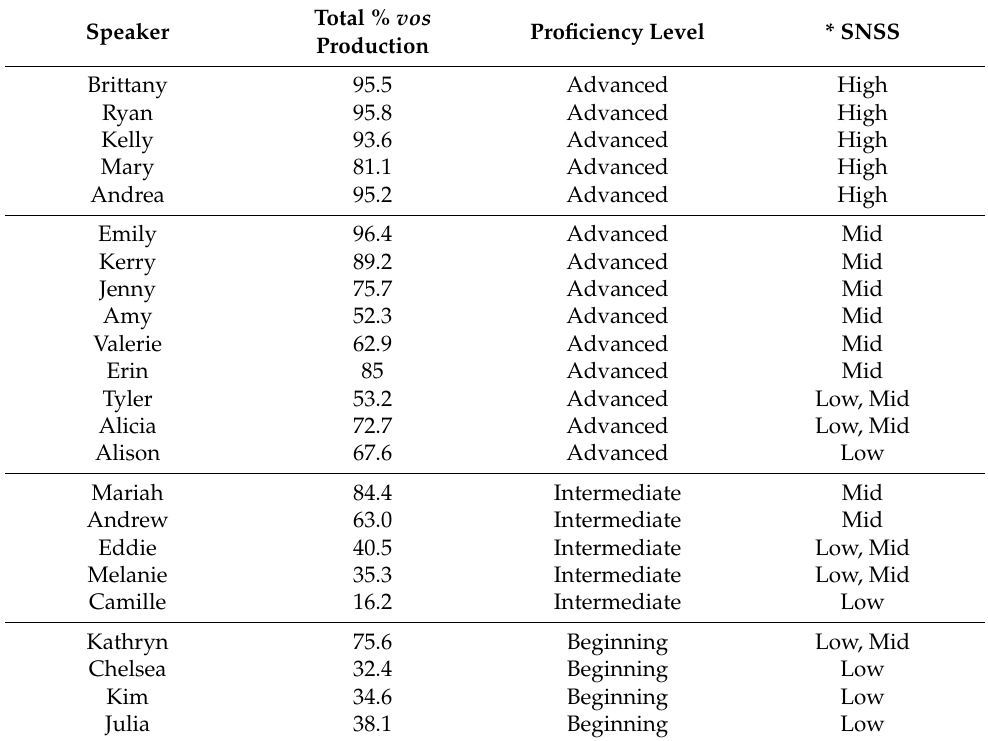
Table 6. Vos Production by Proficiency Level,